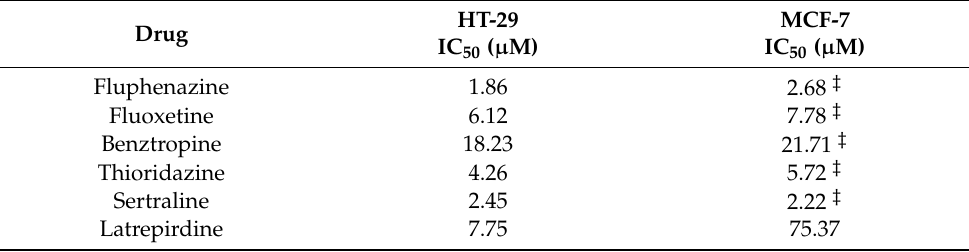
Table 5. Comparison between the IC 50 of several CNS drugs in HT-29 and MCF-7 cancer cells. IC 50 values are given as mean.